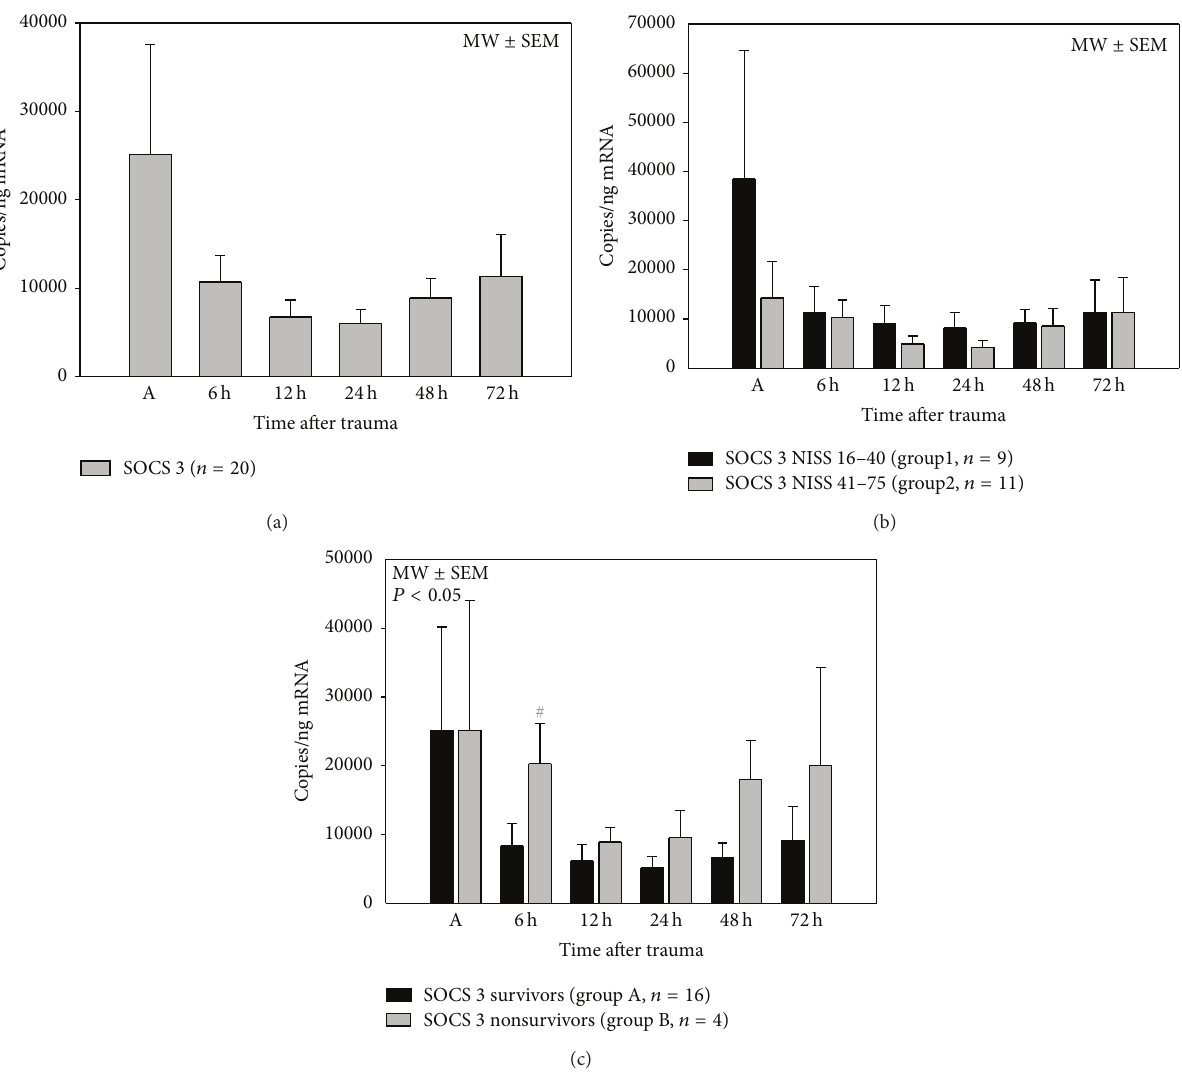
Figure 4: Posttraumatic SOCS 3 mRNA expression profiles after major trauma in all patients (a), depending on injury severity (NISS, (b)) and depending on outcome (survival > 90 days, (c)), # 𝑃 < 0.05 U test. SOCS 3 mRNA expressions showed a high level on admission, followed by a decrease within the first 24 h after trauma in all polytraumatized patients. After the first day, mRNA expression levels increased again until 72 h after injury. Regarding SOCS 3 mRNA expression profiles depending on injury severity, there were no statistically significant differences between groups 1 and 2. Nonsurvivors (group B, 𝑛 = 4 ) showed a significantly higher SOCS 3 mRNA expression level than survivors 6 h after the traumatic